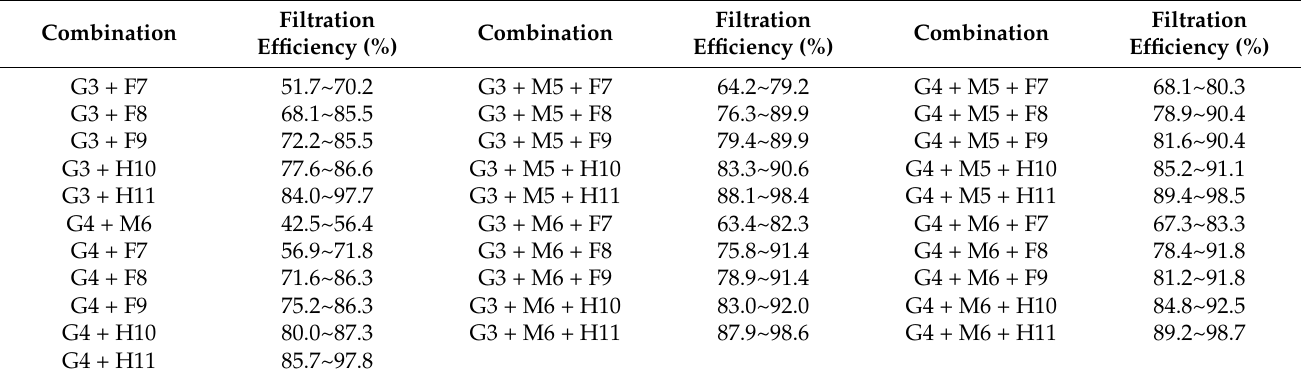
Table 7. The series combination of air